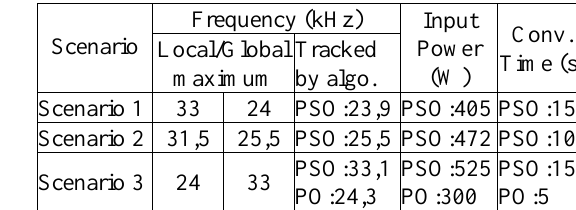
Table 3: Performance evaluation of